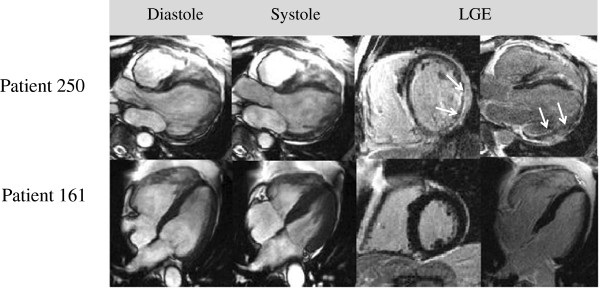
Patients with similar symptoms, but different CMR results and outcomes. Patient 250 presented with dyspnea and chest pain, the same symptoms as patient 161. While in patient 250 CMR revealed an EF of 22% and epicardial LGE of the posterolateral wall typical for myocarditis (EMB: viral HHV6 myocarditis, no other pathology (e.g. no sarcoid)), patient 161 had a normal CMR. Patient 250 died from SCD during follow-up while patient 161 had no events.